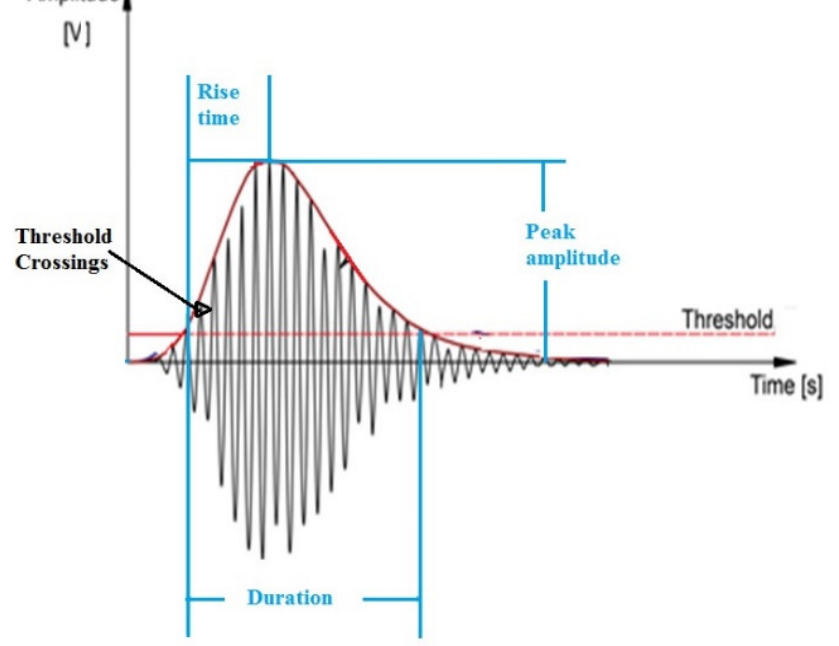
Figure 1. A typical acoustic emission (AE) waveform.